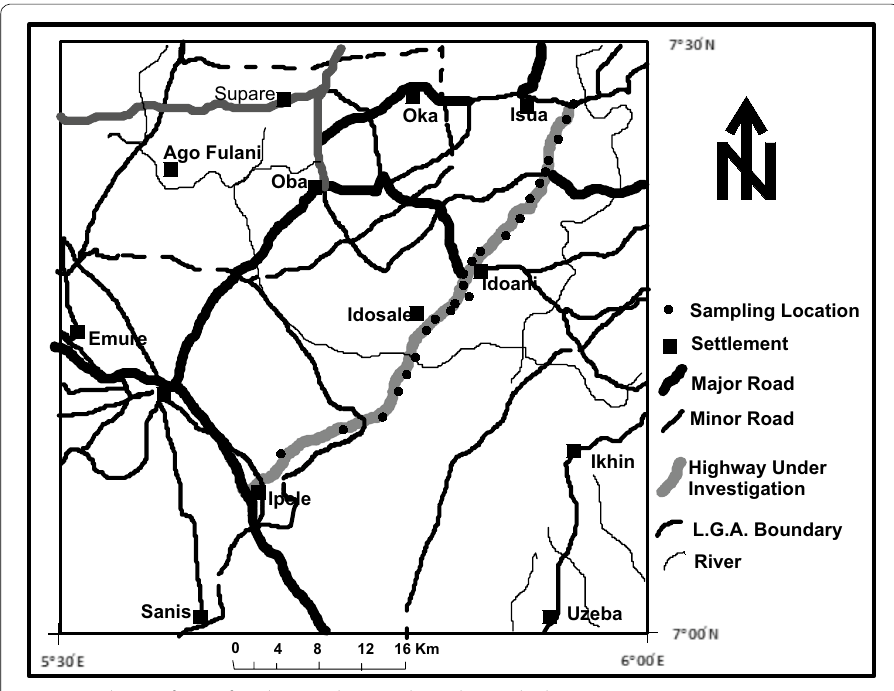
Fig. 1 Road map of part of Ondo state showing the Ipele–Isua